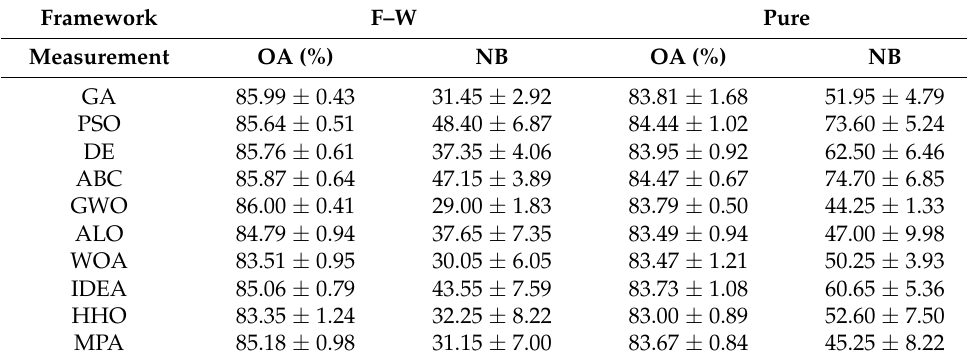
Table 2. The OA and NB of different algorithms on the Indian Pines dataset.